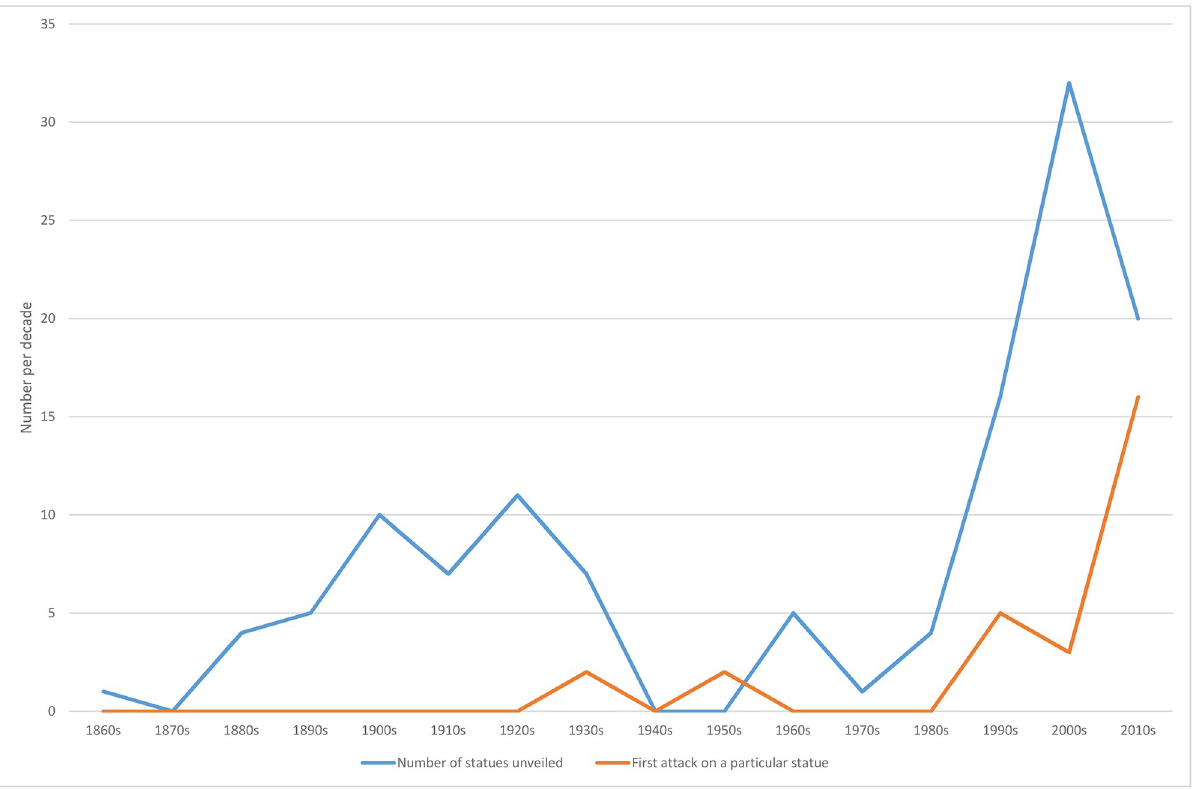
Fig 1. Number of statues of named individuals unveiled in public outdoor settings in New Zealand and first intentional attacks on each statue by decade. (Note: for the last decade, data collection was not quite complete, ie, up to the 13 April 2019 unveiling of the Lithgow statue).